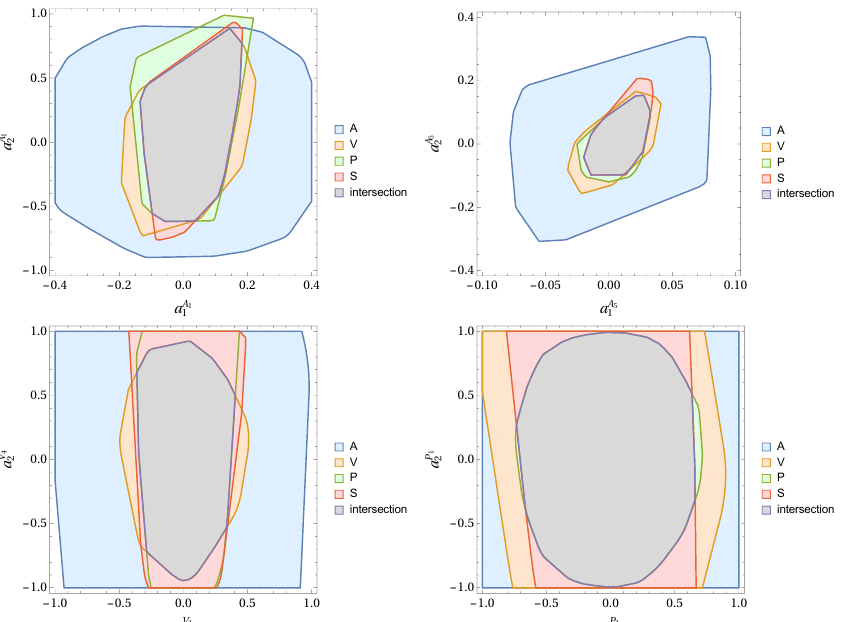
Figure 3 . Allowed regions in the ( a A 1 (S), pseudoscalar (P), vector (V) and axial-vector (A)